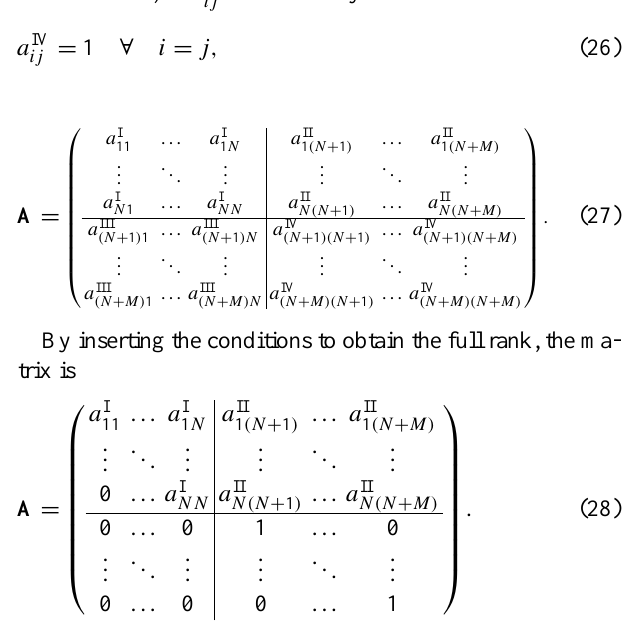
Fig. 5a: Visualization of the multiple charge matrix using only mobility particle size spectrometer data.